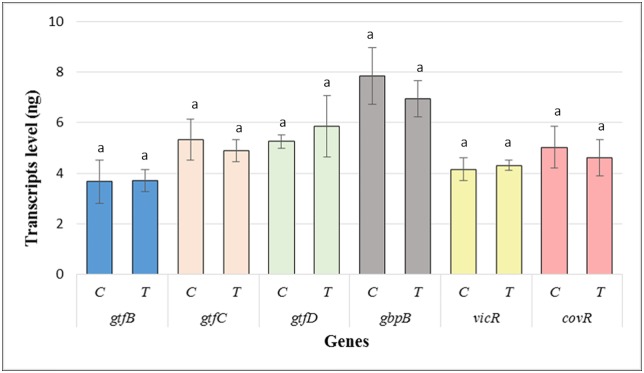
Means (±SD) of the gene expression values in transcript levels (ng) after 24 h of biofilm formation. T–GIC + tt-farnesol; C- GIC (control).